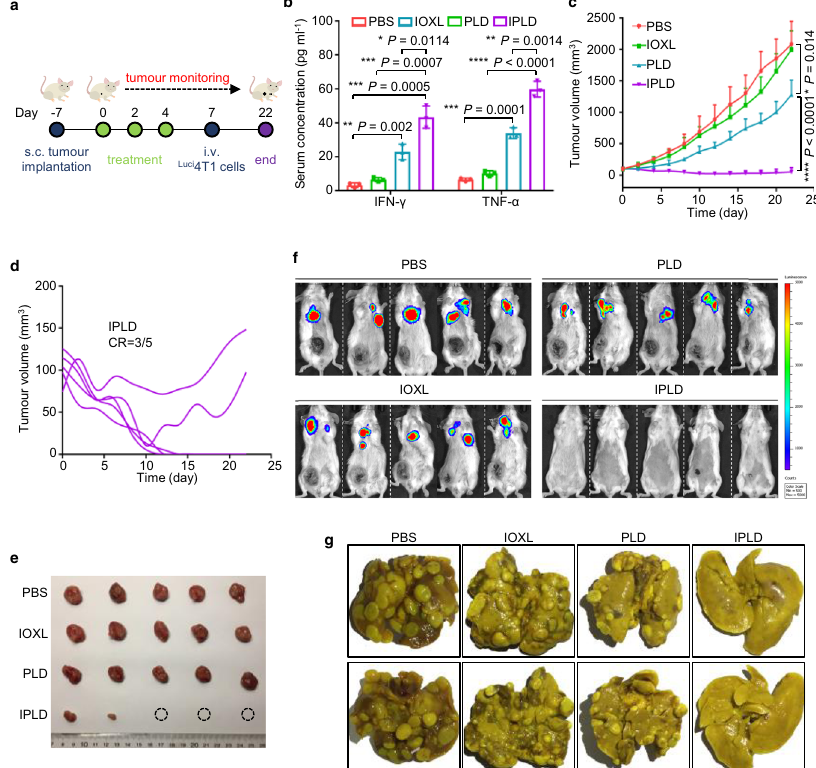
Fig. 8 IPLD treatment of orthotopic and lung metastatic dual tumours of 4T1 triple-negative breast cancer. a Experimental schedule for the dual tumour model: BALB/c mice were s.c. inoculated with 1 × 10 6 4T1 cells at the left mammary gland; when the tumours reached about 100 mm 3 , the treatments were initiated (noted as Day 0) with the liposome formulas at 7.5 mgkg − 1 IOX1, 5mg kg − 1 DOX or their combination every 2 days for three times; 3 days after the last treatment (Day 7), Luci 4T1 cells (5× 10 5 ) were injected to the mice via the tail vein. b The serum IFN- γ and TNF- α levels in the mice determined on day 9; n = 3 mice. c The tumour growth curves of the orthotopic 4T1 tumours; n = 5 mice. d The individual tumour growth of each mouse in the IPLD-treated group; CR: complete response. e The images of the tumours dissected at the end of the experiment (Day 22). f In vivo live bioluminescence imaging the Luci 4T1 tumours in lungs on day 22; n = 5 mice. g Representative photographs of the lungs dissected from the mice on day 22. Data represent mean ±SD. Two-tailed Student ’ s t test. * P < 0.05, ** P < 0.01, *** P < 0.001, **** P < 0.0001. Source data are provided as a Source Data fi (Fig. 6a-c), and more mDCs (Fig. 6d,e) and active CTLs (Fig. 6f,g) orthotopic (Fig. 8d,e) and the distant lung metastatic tumours but less Tregs (Fig. 6k,l), as well as higher levels of antitumour- (Fig. 8f,g), as resulted from the activated antitumour immunity 66 . The left 2 mice only partially responded, but their primary and associated cytokines including IFN- γ , TNF- α , IL-2, and IL-6 metastasis tumours were far smaller and less (in the lung) than (Fig. 6n) but unchanged anti-in fl ammatory cytokine IL-10 those of the PLD group. (known detrimental to antitumour immune response 65 ). All CR in immunocompetent mice compared with the partial response in immunocompromised nude mice after the same IPLD treatment clearly re fl ected the contribution of the IOX1-induced immune responses to antitumour activity (Fig. 5h).